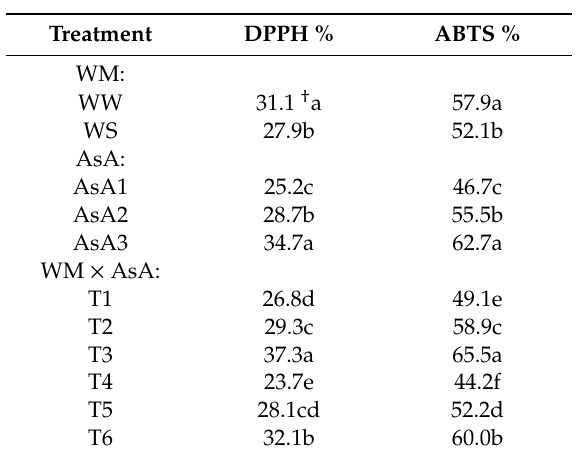
† Mean values within the same column for each trait with the same lower-case letter are not significantly di ff erent according to Tukey’s HSD (honestly significant di ff erence) test at p ≤ 0.05. Measurements were done at 46 day after sowing. WW, well watered with 100% of evapotranspiration (ETc) throughout the season; WS, water stress with 50% of ETc throughout the season; AsA1, 0 mg L − 1 AsA; AsA2, 200 mg L − 1 AsA; AsA3, 400 mg L − 1 AsA; T1,